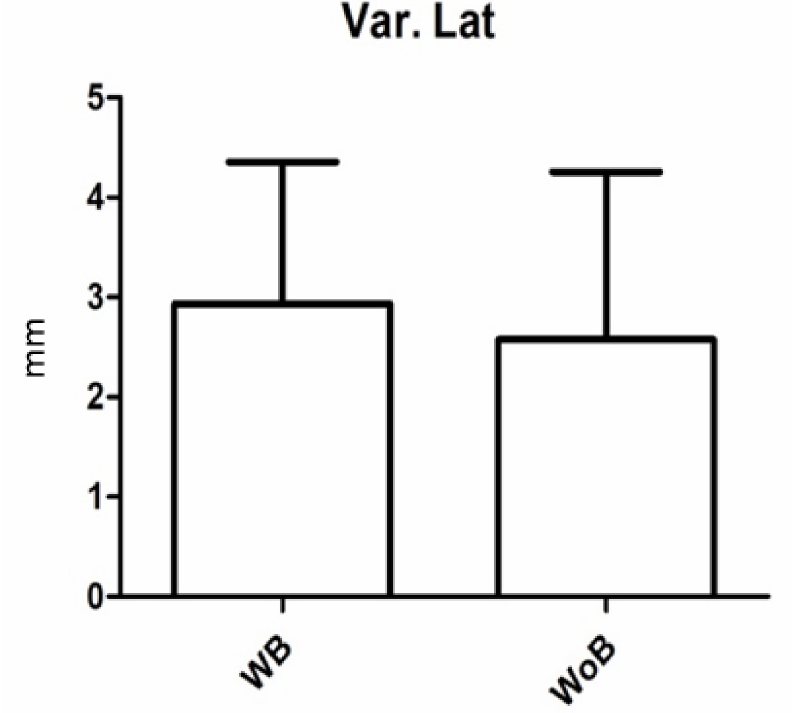
Figure 2. Variation of the laterolateral oscillation (mm) in the baropodometric measurement with (WB) and without (WoB) a brace. Error bars represent Standard Error